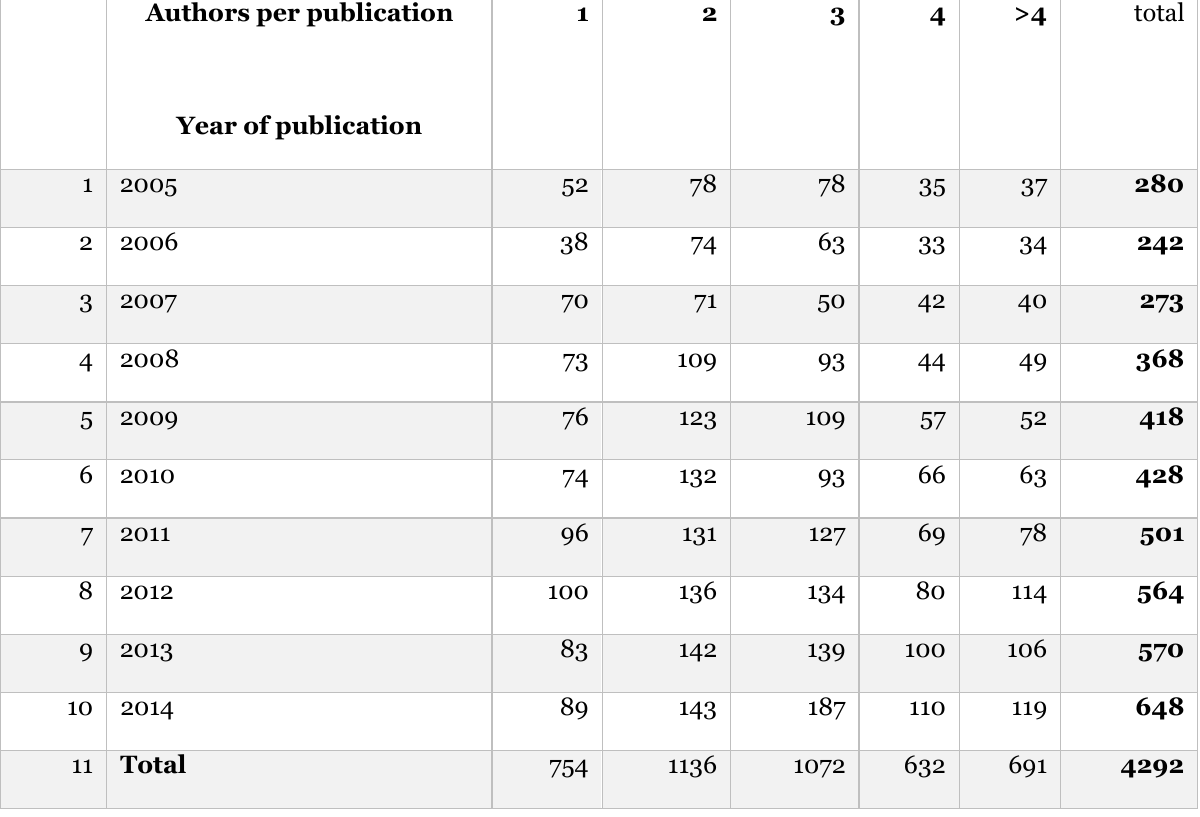
Collaboration Rate of Authors, by